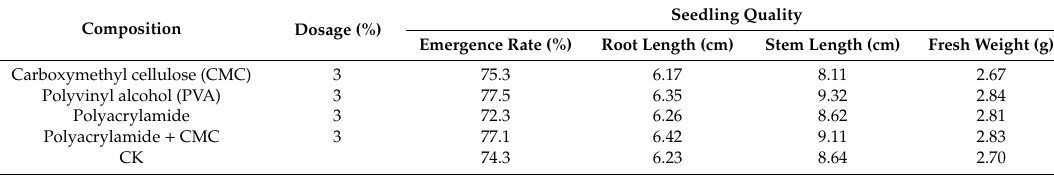
Table 3. The main components of seed coating.